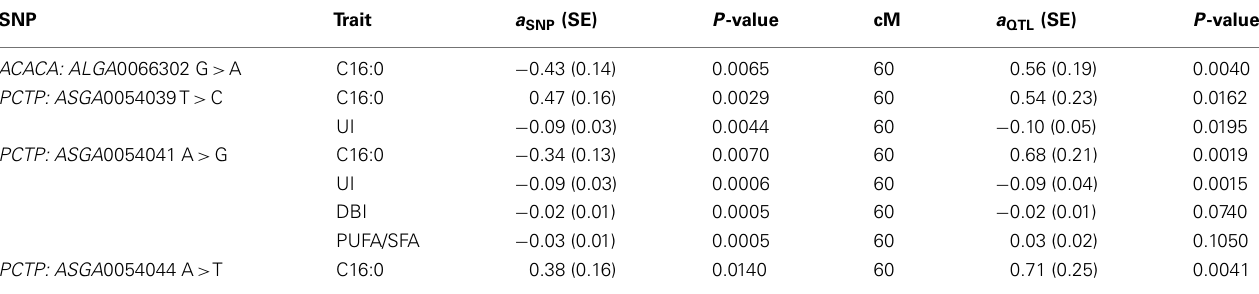
Table 4 | Marker-assisted association tests: Results for ACACA and PCTP SNPs significantly associated for fatty acid composition in previous analyses.